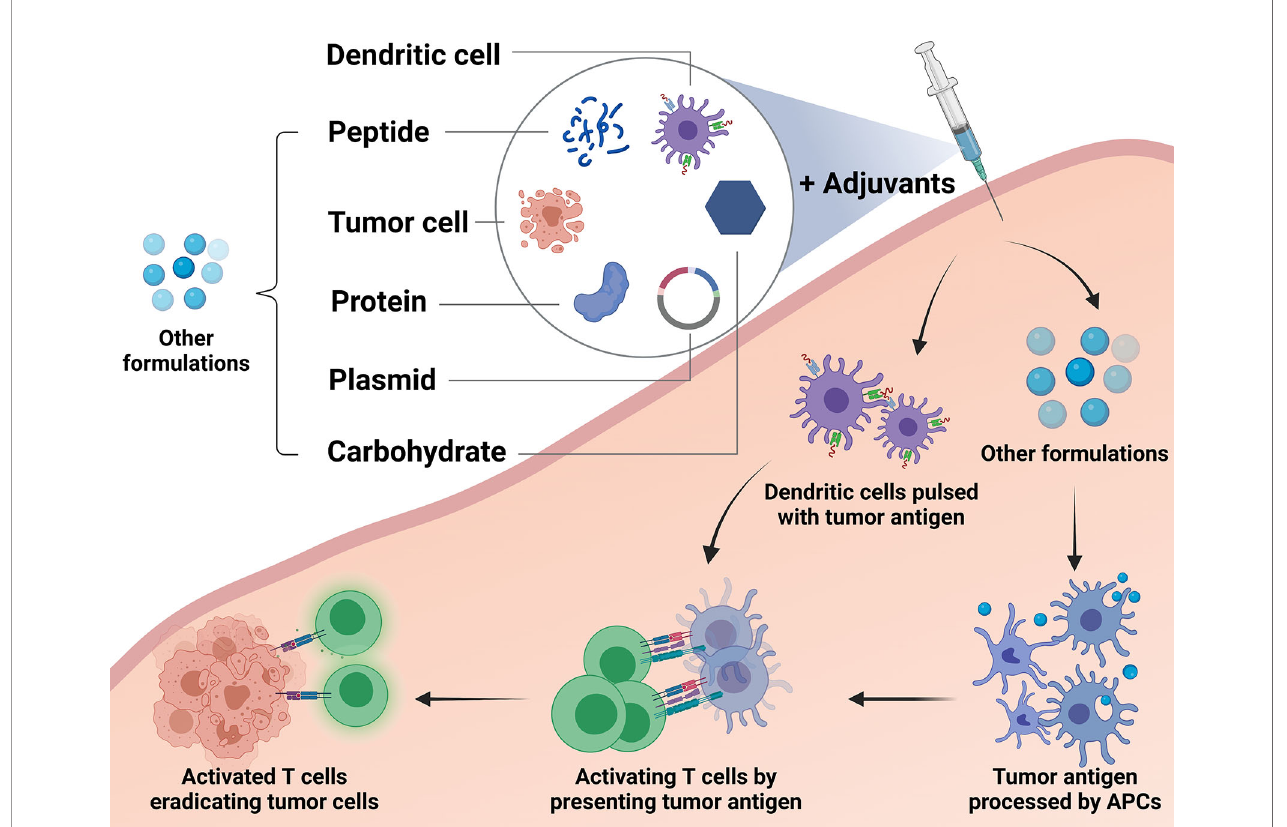
FIGURE 2 | Different types of breast cancer vaccines and their mechanisms. The studied breast cancer vaccines can be divided into the following types according to their formulations and approaches: peptide vaccine, protein-based vaccine, carbohydrate antigen vaccine, DNA-based vaccine, dendritic cell-based (DC-based) vaccine, and tumor cell vaccine. DC-based vaccines utilize ex vivo generation of DCs loaded with tumor antigens or transfected to express tumor antigens. These cells process the antigens and present them to T cells directly by themselves in order to activate an immune response. Except the dendritic cells, other formulations applied in the vaccines, including peptide, protein, plasmid, carbohydrate and tumor cell, need to stimulate the autologous antigen presenting cells (APCs). Then the autologous APCs will activate the effector immune cells to boost an anti-tumor